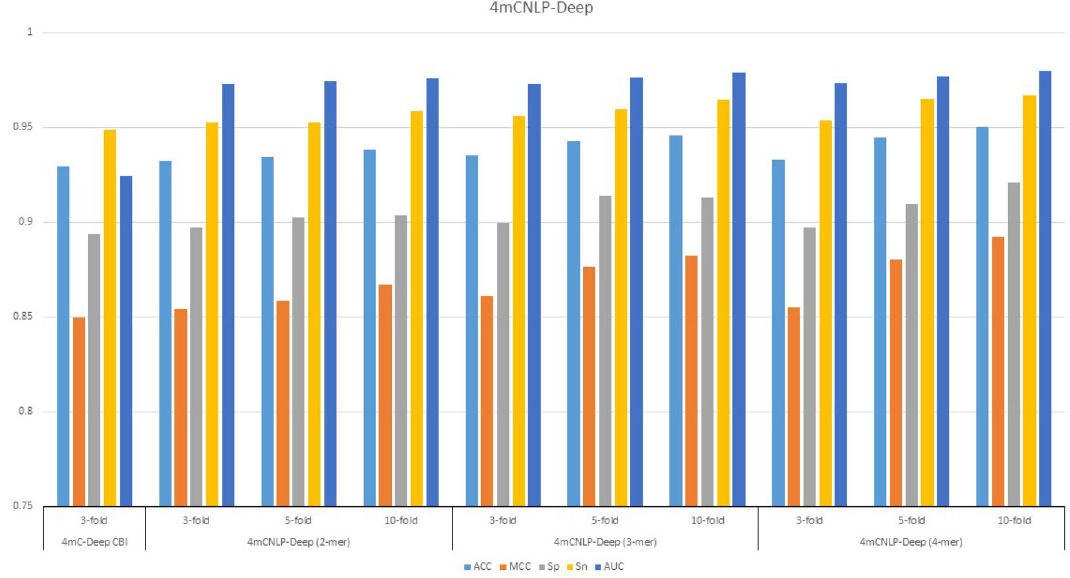
Figure 2. Depiction of performance comparison of 4mCNLP-Deep and existing model with various experimental